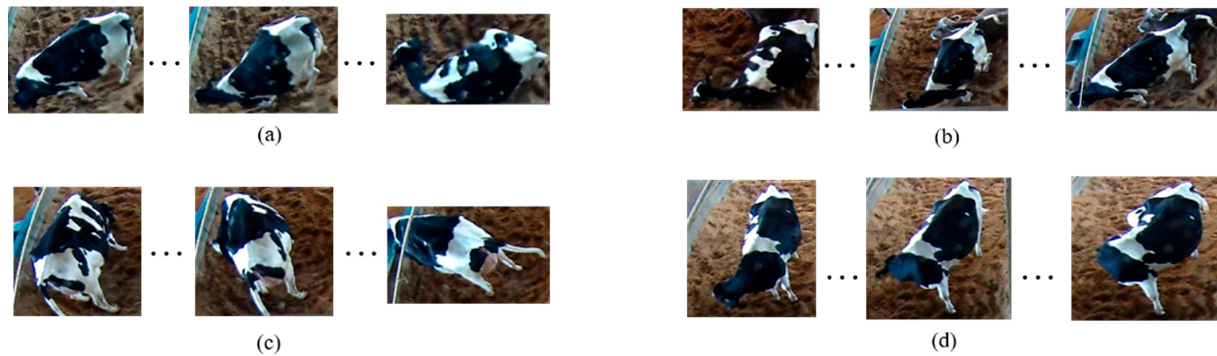
Figure 1. Bovine activities: ( a ) Lying down, ( b ) standing up, ( c ) holding up the tail, ( d ) turning the head